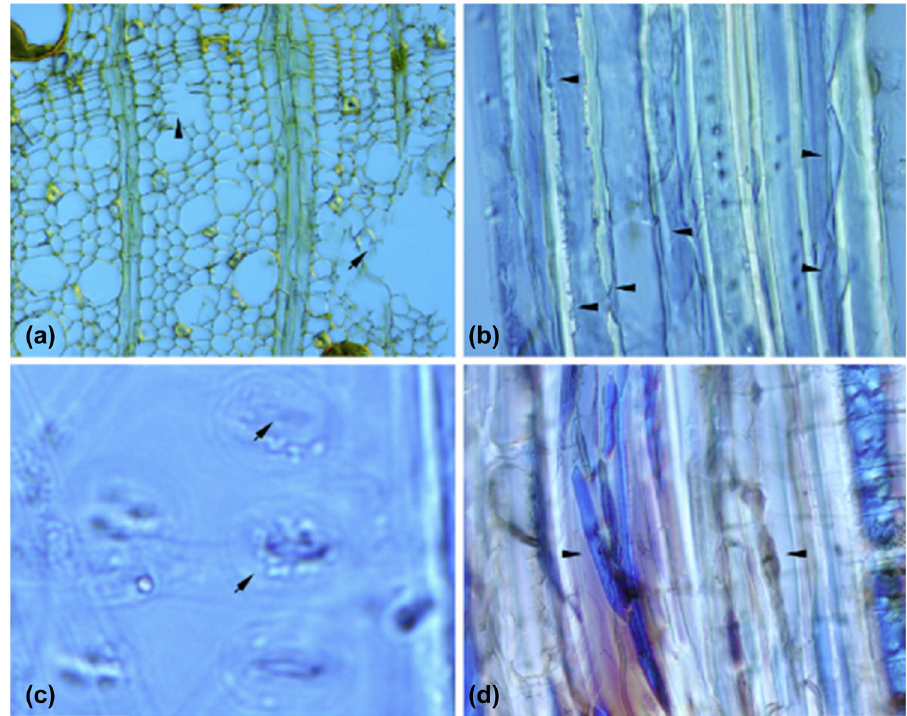
Figure 3: Severe biodegradation in nonacetylated beech: ( a ) and ( b ) White rot decay ( arrow heads ) ; Nomarsky. ( a ) cross section; Nomarsky. ( b ) Radial section; Nomarsky. ( c ) Bacterial degradation in pits ( arrow heads ) ; radial section, Nomarsky. ( d ) Soft rot decay ( arrow heads ) ; radial section, Nomarsky [ 43 ] .